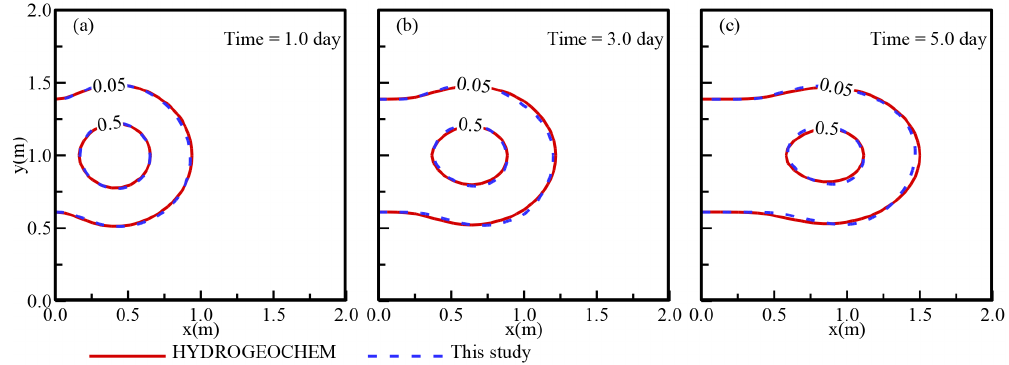
Figure 6. Comparison of the concentration distributions for the developed DFN model (dashed lines) and the HYDROGEOCHEM model (solid lines) for a horizontal fracture plate.